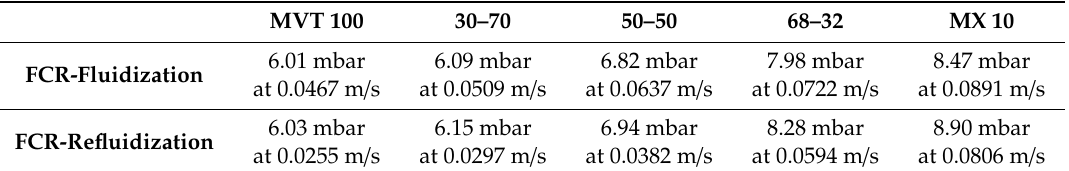
Table 8. Value and corresponding superficial gas velocity of the peak of bed pressure drop (FCR test results) for the applied pressure of 40 kPa during compression.